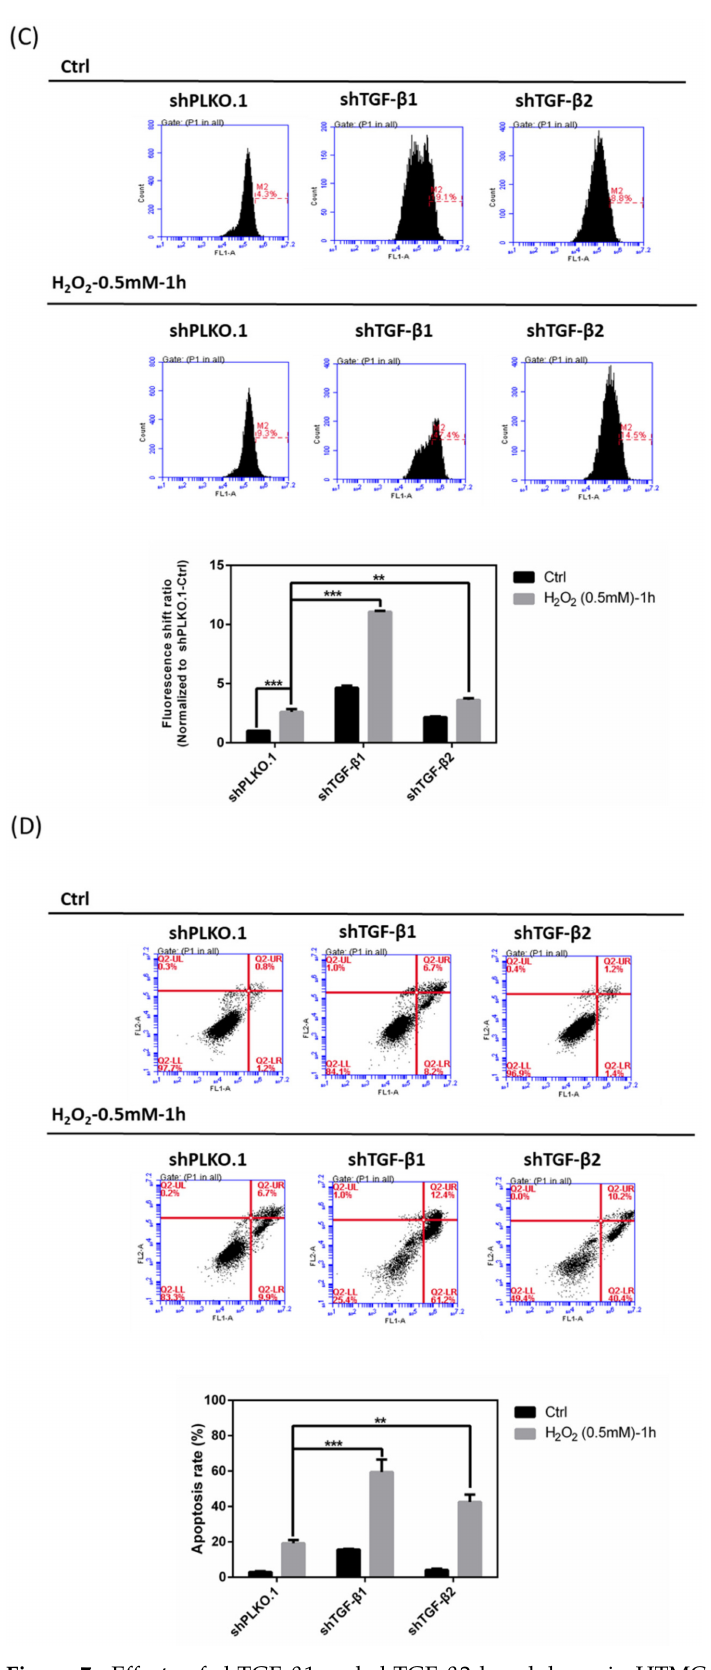
Figure 7. Effects of shTGF- β 1 and shTGF- β 2 knockdown in HTMCs with H 2 O 2 exposure. ( A ) TGF- β 1/2 knockdown HTMCs had decreased cell viability with H 2 O 2 at different concentrations